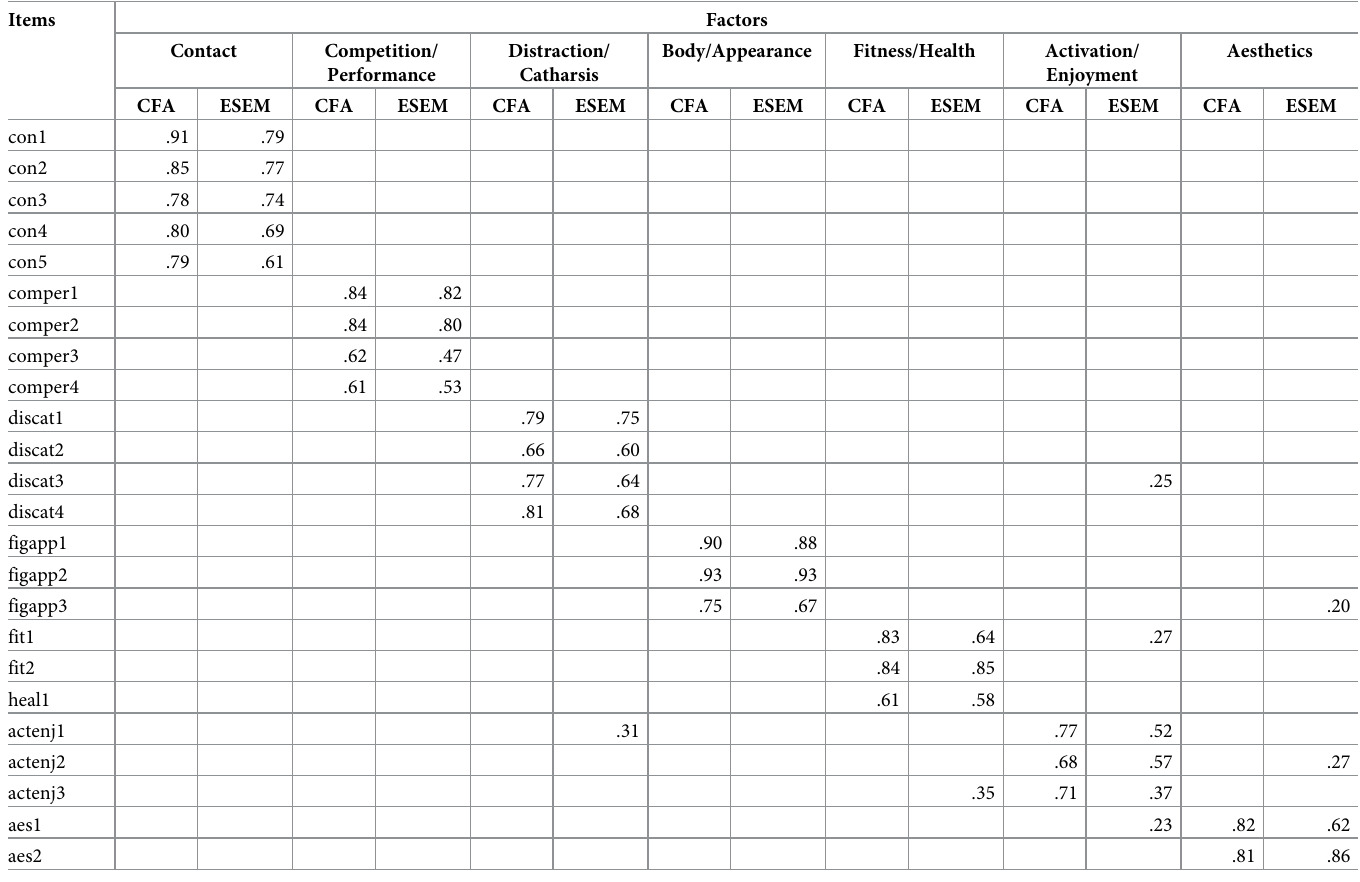
Table 2. Factor loadings of the original BMZI in sample